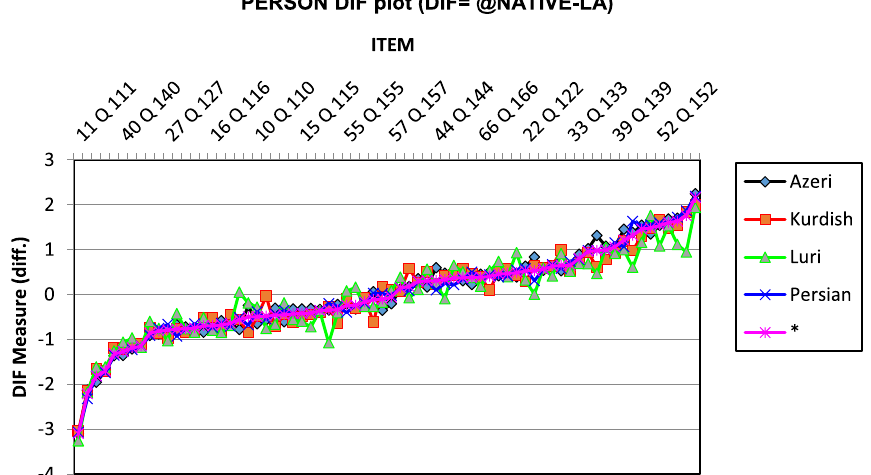
Fig. 4 Uniform differential item functioning in the Iranian Undergraduate University Entrance Special English IUUESEE